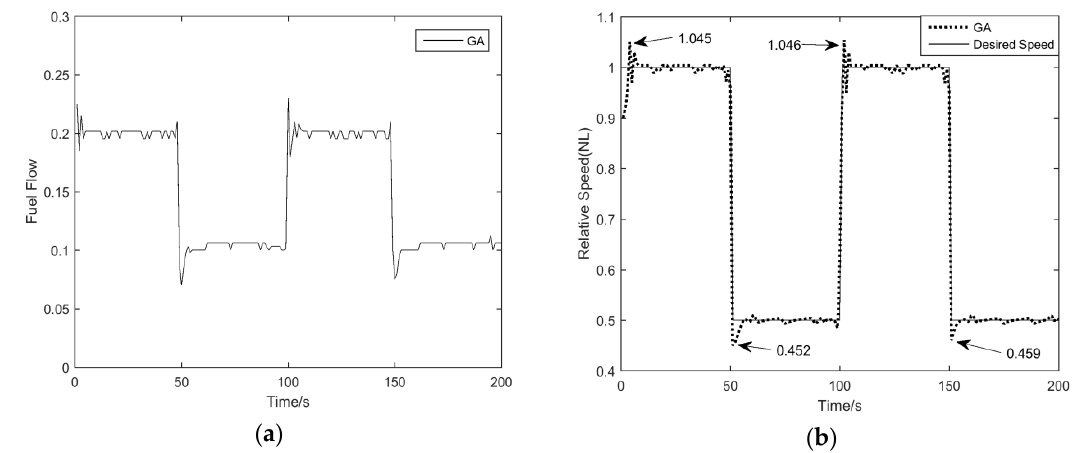
Figure 11. The simulation results of NMPC based on HGWO. ( a ) Fuel flow curve; ( b ) relative speed curve.